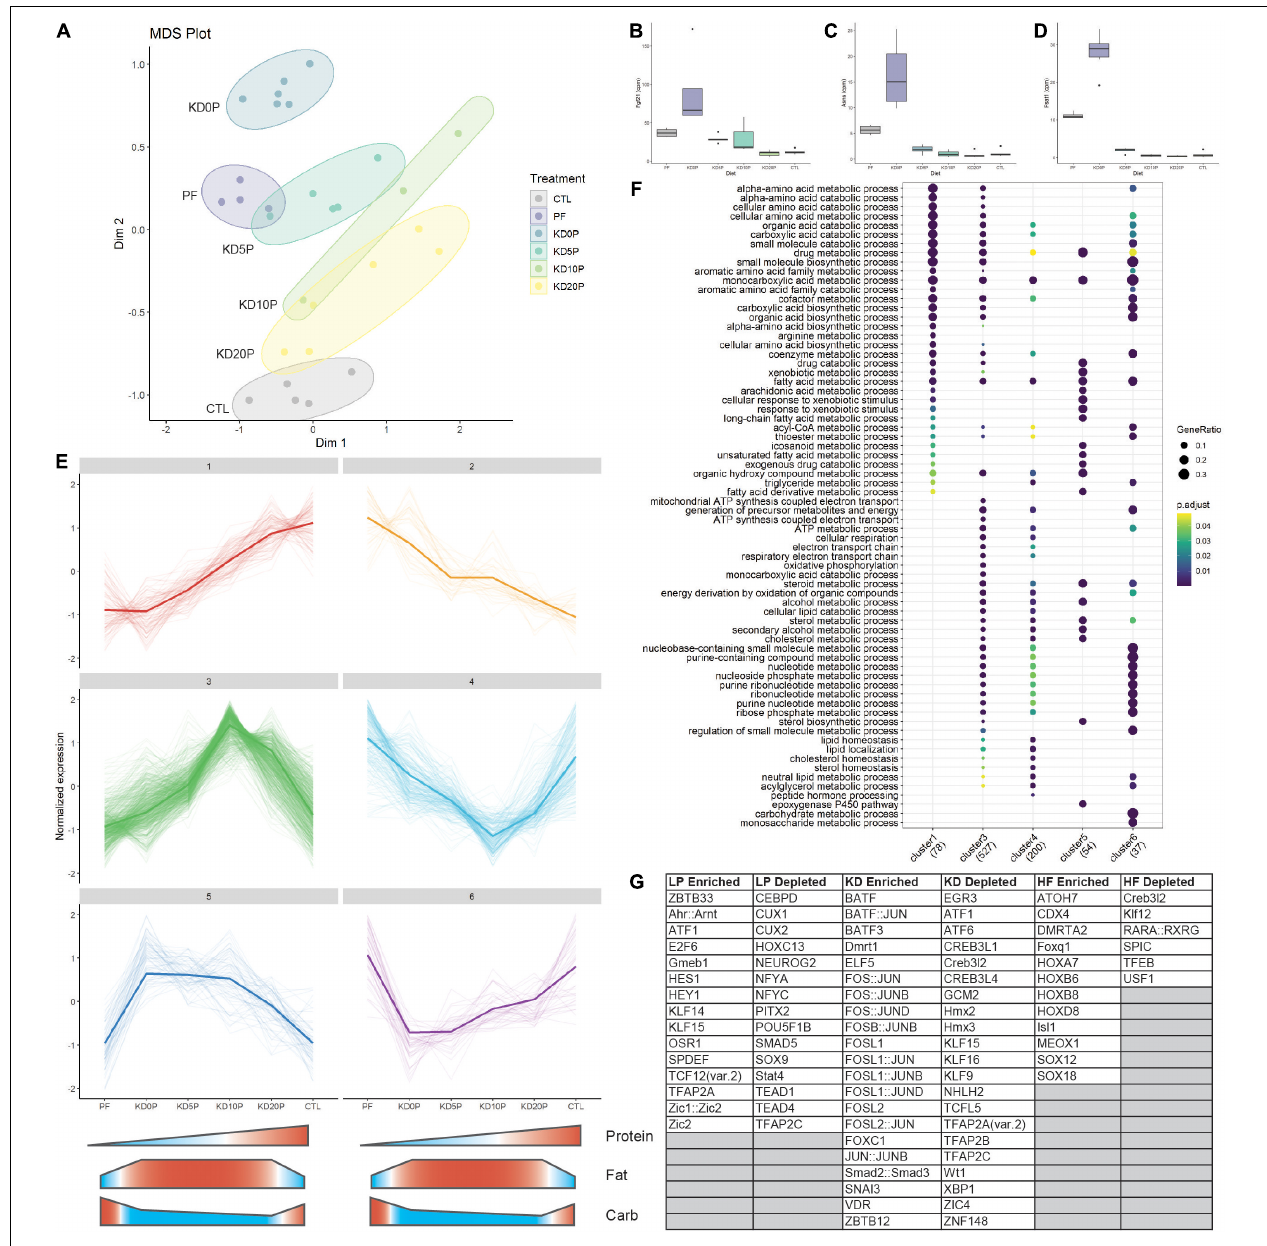
FIGURE 4 | Protein-free and ketogenic diets produce distinct hepatic transcriptomic signatures. (A) Multidimensional scaling (MDS) plot across all diet groups/samples. (B) Expression of amino acid responsive genes Fgf21, (C) Asns and (D) Psat1 presented at counts per million (cpm). (E) Cluster analysis of the top 10% of most variable genes in the dataset. Clusters 1 and 2 represent protein-responsive genes. Clusters 3 and 4 represent genes responding to classic ketogenic diet. Clusters 5 and 6 include genes responsive to dietary fat content. (F) Pathway over-representation analysis of genes from the clusters identified in (E) . (G) Enriched and depleted transcription factor (TF) binding motifs in the clusters identified in E. LP enriched includes TF binding motifs which are significantly depleted in cluster 1 and significantly enriched in cluster 2. The same method was used for KD in clusters 3 and 4 and high fat (HF) in clusters 5 and